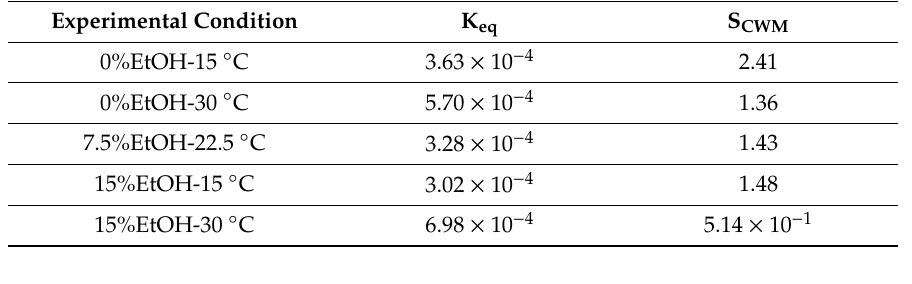
Table 1. Langmuir equation constants for each experimental condition. Values derived via regression analysis of experimental data fit to the Langmuir